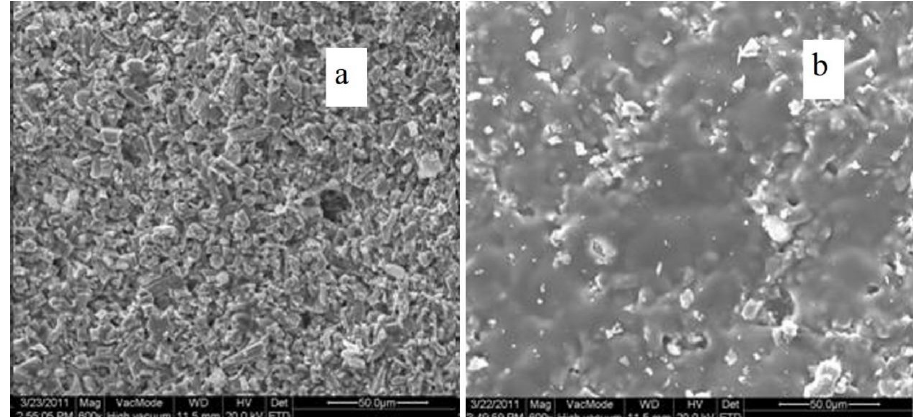
Figure 6. Micro morphology of the untreated ( a ) and treated ( b ) cinnabar samples.